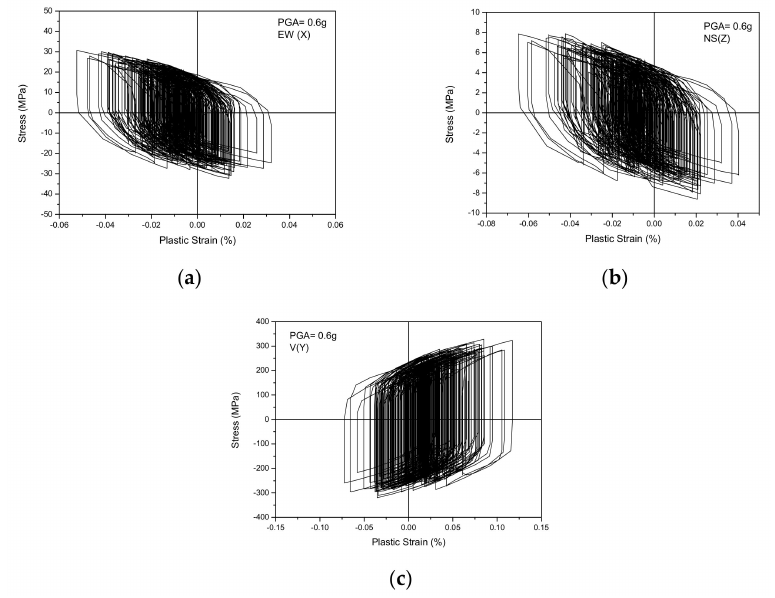
Figure 18. Hysteretic behavior of the material at the location of the maximum accumulated equivalent plastic strain for PGA = 0.6 g: ( a ) EW (X); ( b ) NS (Z); ( c ) V (Y).